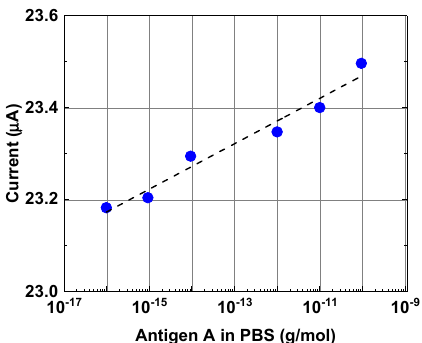
13 of 18 Figure 9. SEM image of a 45 μ m × 150 μ m graphene chip from Group 1. Inset 1 ( left, top ) shows a 5 μ m × 5 μ m section with boundaries of functionalized graphene (dark areas) and non-functionalized graphene (light area in the middle). Inset 2 ( right, bottom ) shows a 2.7 μ m × 4.2 μ m region with virus aggregates, located in a recess with a facet close to a hexagonal structure. 3.2. Study of Immobilization of Antibodies of Influenza A and B Viruses, Antibody–Influenza Immune Reaction, and Detection of Influenza Viruses by Biosensors Based on Graphene Chips The conventionally accepted method described in Section 2.3 was used to detect the influenza viruses (antigens) [2]. Influenza virus antigens were diluted in PBS. In the experiment, the current passing through the chip was measured versus the concentration of antigens of influenza A viruses in PBS in the concentration range of 10 − 16 g/mL to 10 − 10 g/mL. Figure 10 shows an almost monotonic increase in the magnitude of the response, which is approximated by a logarithmic function with the parameter R 2 close to 1 (0.96) in